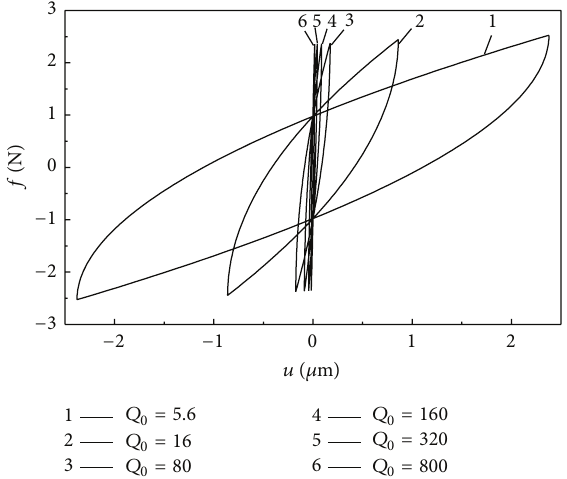
Figure 10: Resonance hysteresis loops of dry friction blade with shroud